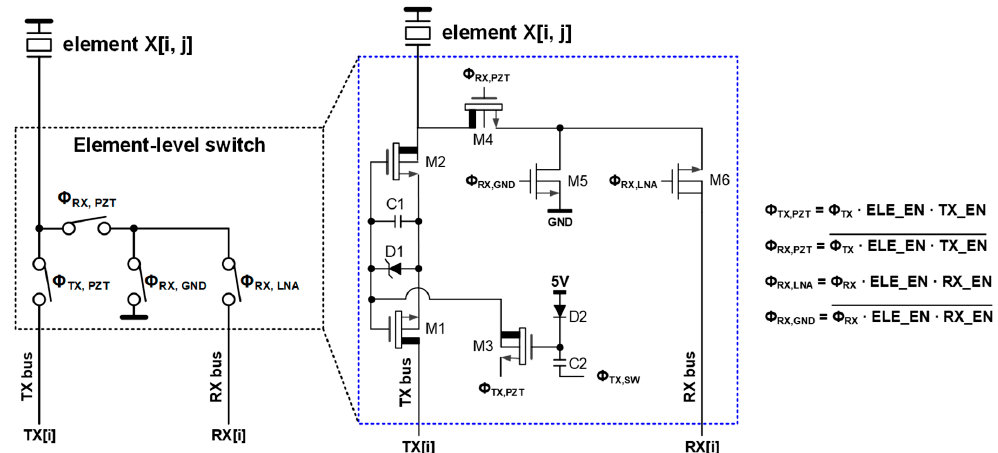
Figure 4. Simplified circuit diagram of the element-level switch and the combinational logic equation, implemented as the switch controller, proposed in [17].